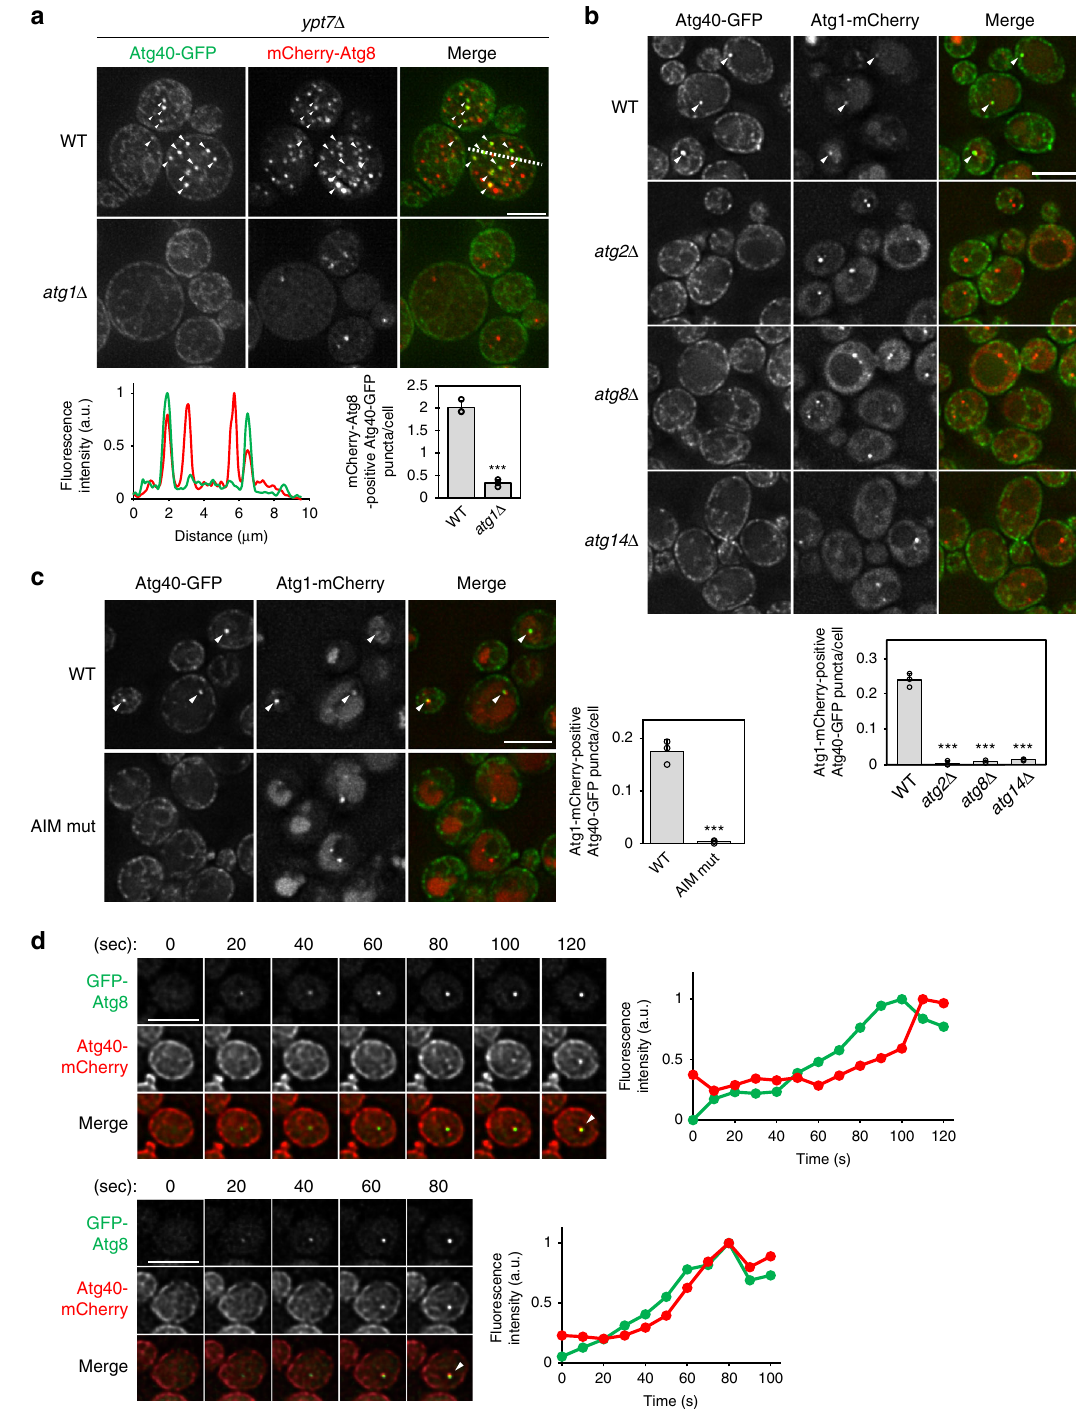
Fig. 3 Atg40 is assembled at ER-isolation membrane contact sites through its interaction with Atg8. a ypt7 Δ cells coexpressing Atg40-GFP and mCherry-Atg8 were treated with rapamycin for 6 h, and observed under a fl uorescence microscope. The images are maximum-intensity projections of Z stacks (seven plane stacks, 0.2- μ m spacing). Atg40-GFP puncta that colocalized with mCherry-Atg8 (arrowheads) were counted, and the results of quanti fi cation are shown as means ± s.d. ( n = 3). Line scan analysis of dashed line shows the normalized fl uorescence intensity. b , c Cells were treated with rapamycin for 3 h and observed under a fl uorescence microscope. Atg40-GFP puncta that colocalized with Atg1-mCherry (arrowheads) were counted, and the results of quanti fi cation are shown as means± s.d. ( n = 3). d Cells were treated with rapamycin for 15 min and observed under a fl uorescence microscope. Images were taken at 10-s intervals. Fluorescence intensity of GFP-Atg8 and Atg40-mCherry puncta are shown (see “ Methods ” ). *** P = 8.02 × 10 − 5 ( a ), *** P = 3.67 × 10 − 5 (b, atg2 Δ ), *** P = 3.44 × 10 − 5 (b, atg8 Δ ), *** P = 3.55 × 10 − 5 (b, atg14 Δ ), *** P = 1.91 × 10 − 4 ( c ) (unpaired two-tailed Student ’ s t test). Scale bars, 5 μ